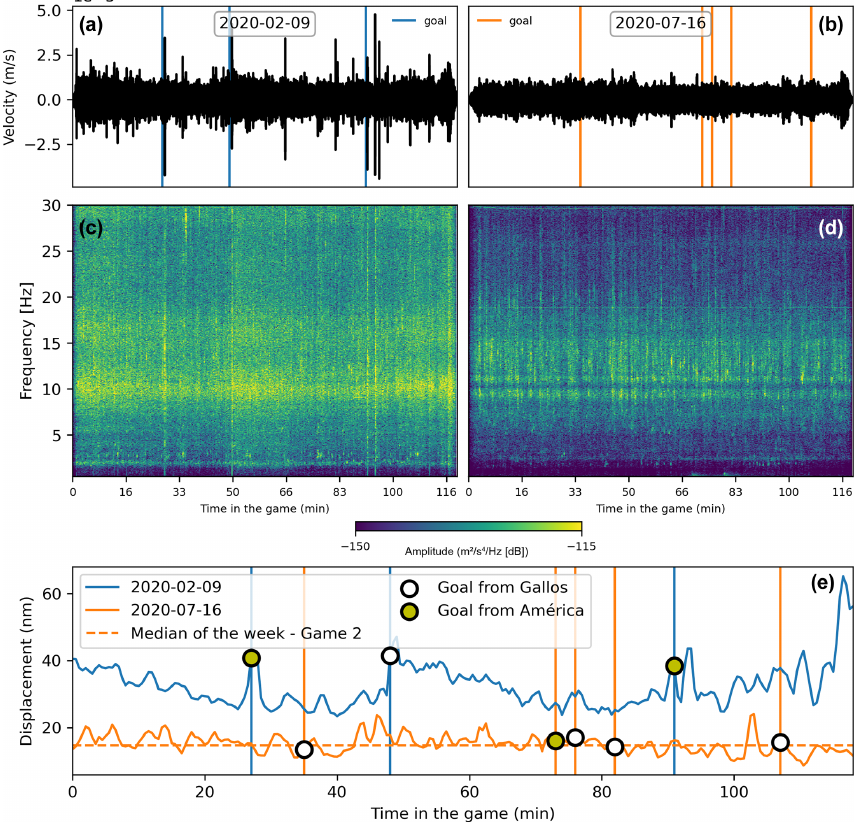
Figure 7. Seismic signal recorded by station REBDD during the football games between the Gallos Blancos of Querétaro and the Club América of Mexico City in the Corregidora soccer arena on 9 February and 16 July 2020, respectively. Panels (a) and (b) are the waveforms, and panels (c) and (d) the spectrograms for each respective game. Panel (e) compares the seismic rms between the two games in the 4–14Hz frequency